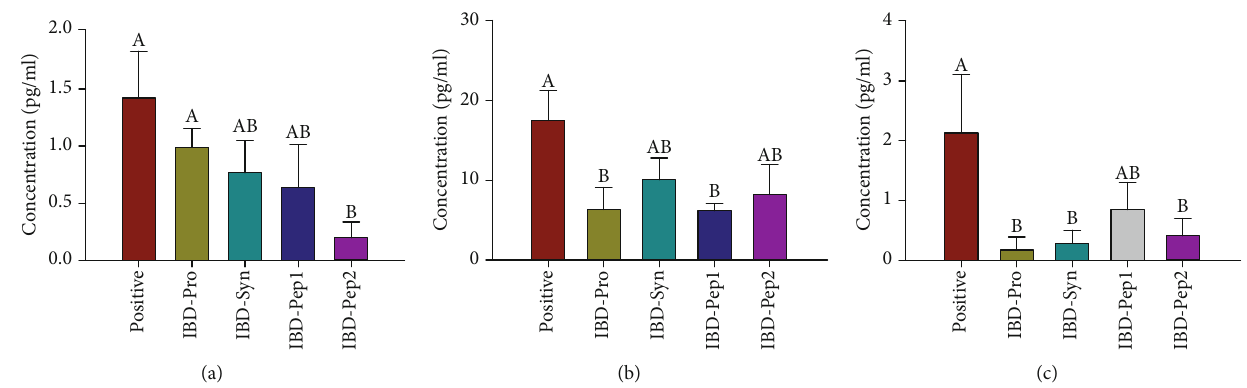
Figure 2: In fl ammatory cytokine levels in the serum: (a) IFN- γ , (b) IL-6, and (c) TNF- α . A,B Values are signi fi cantly di ff erent ( p < 0 : 05 ).